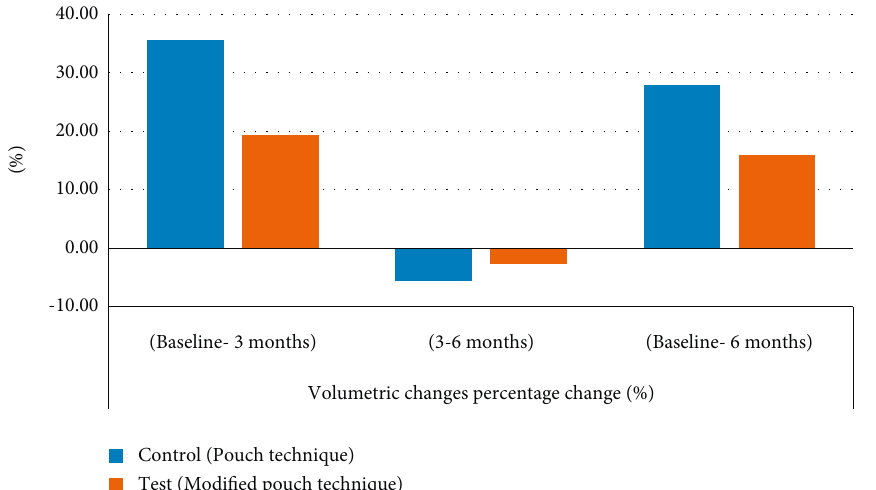
Figure 7: Bar chart showing average values of percent change (%) in soft tissue volumetric changes within each group at different study intervals. Table 2: Mean and SD values of post-operative pain (VAS) within each group at days 3, 7, and 14